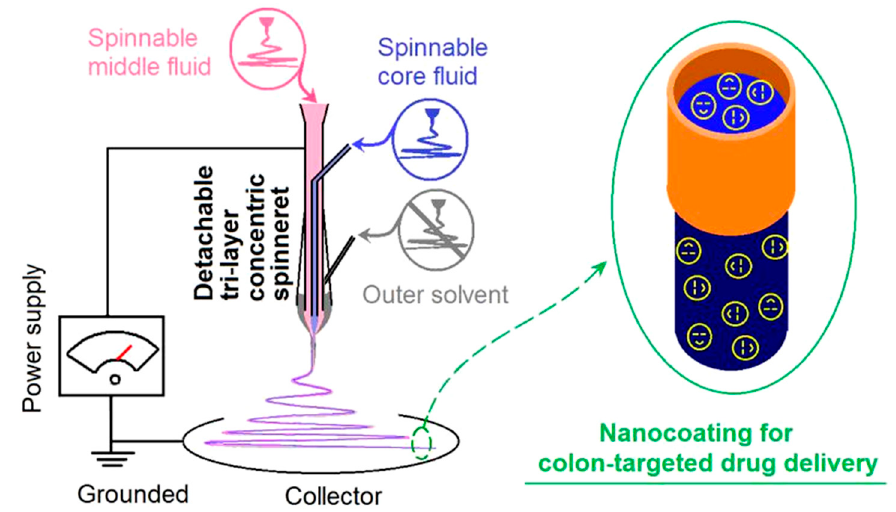
Figure 1. A diagram of the modified coaxial electrospinning.